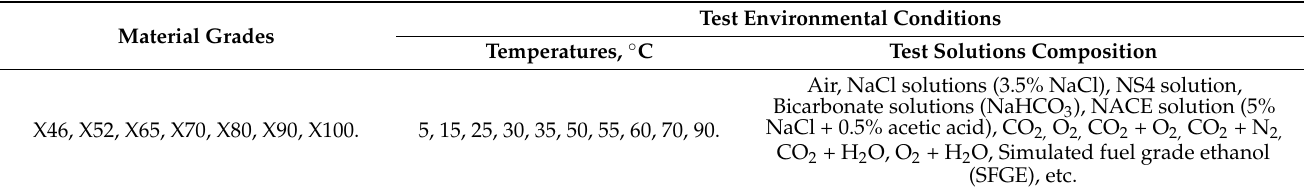
Table 1. Chemical compositions of API 5L X65, X70 and X80 pipeline steel (wt.%). [14,33]. Reprinted Table 2. SCC susceptibility test environmental conditions. Data from [14,16,33]. with permission from [14,33], 2008, 2019, Elsevier. Material